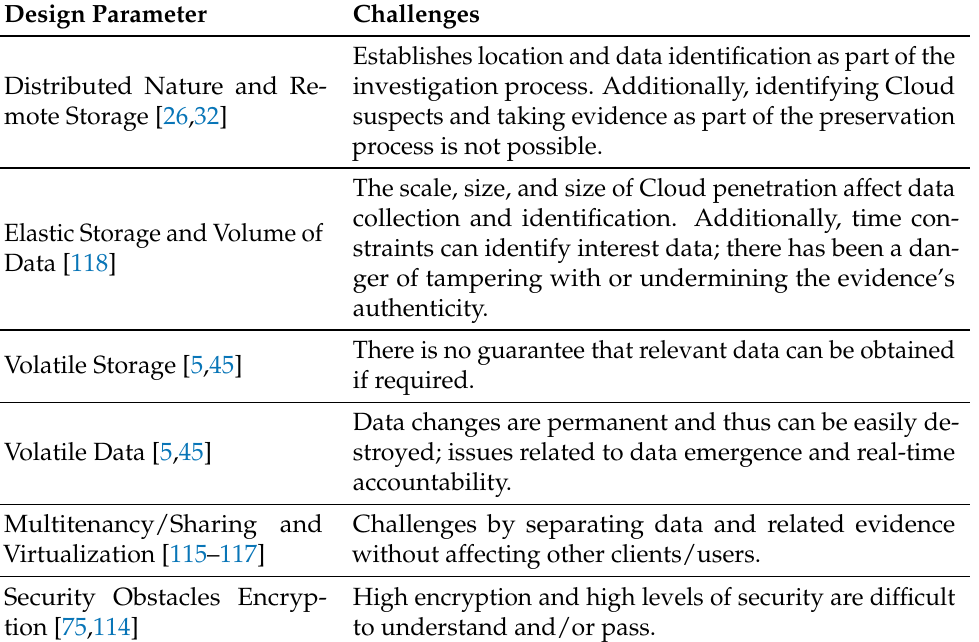
Table 4. Cloud forensics: technical